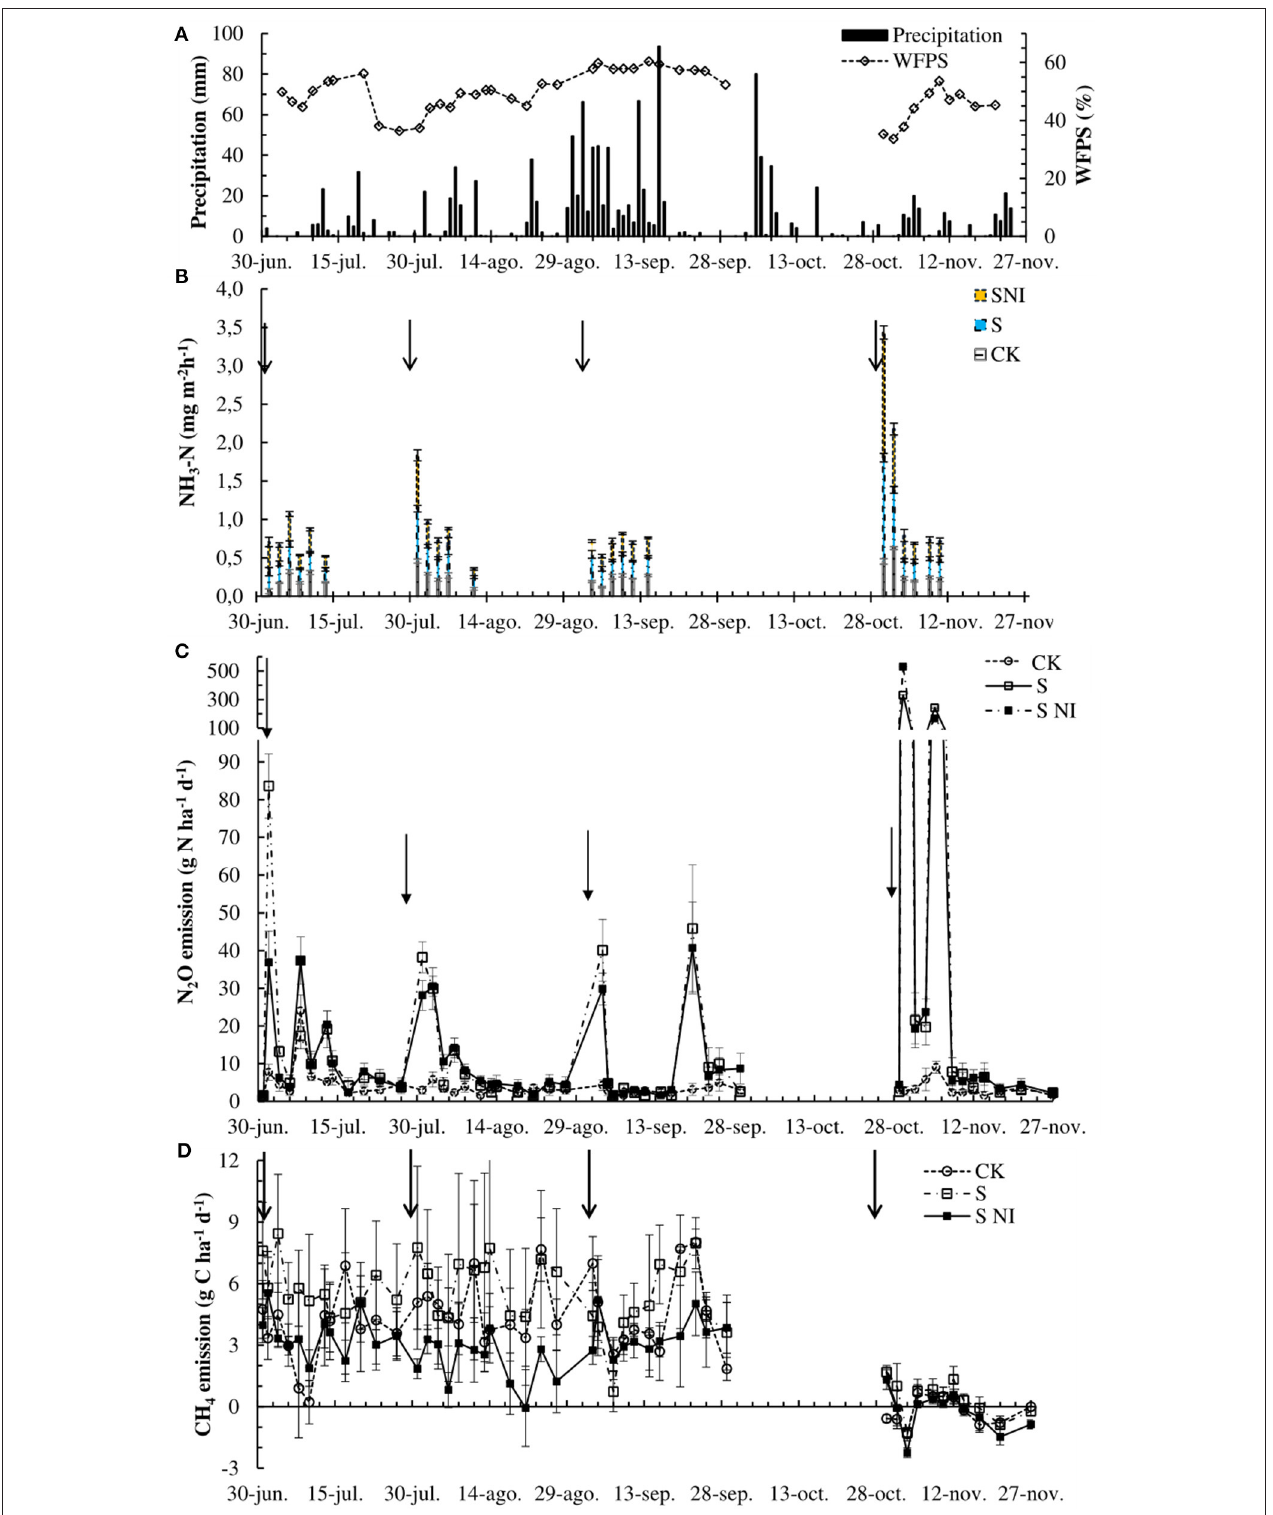
FIGURE 1 | Precipitation and water-filled pore space (WFPS) in top 10-cm of soil (A) . Ammonia (NH 3 ) (B) , nitrous oxide (N 2 O) (C) , and methane (CH 4 ) (D) flux from control (CK), dairy farm effluents (S), and dairy farm effluents plus nitrapyrin (SNI) of a field trial conducted in 2017 on a permanent pasture in the Alfredo Volio Mata Experimental Station, Costa Rica. Vertical bars indicate the standard error ( n = 5). Arrows indicate the moment when dairy farm effluents were applied.